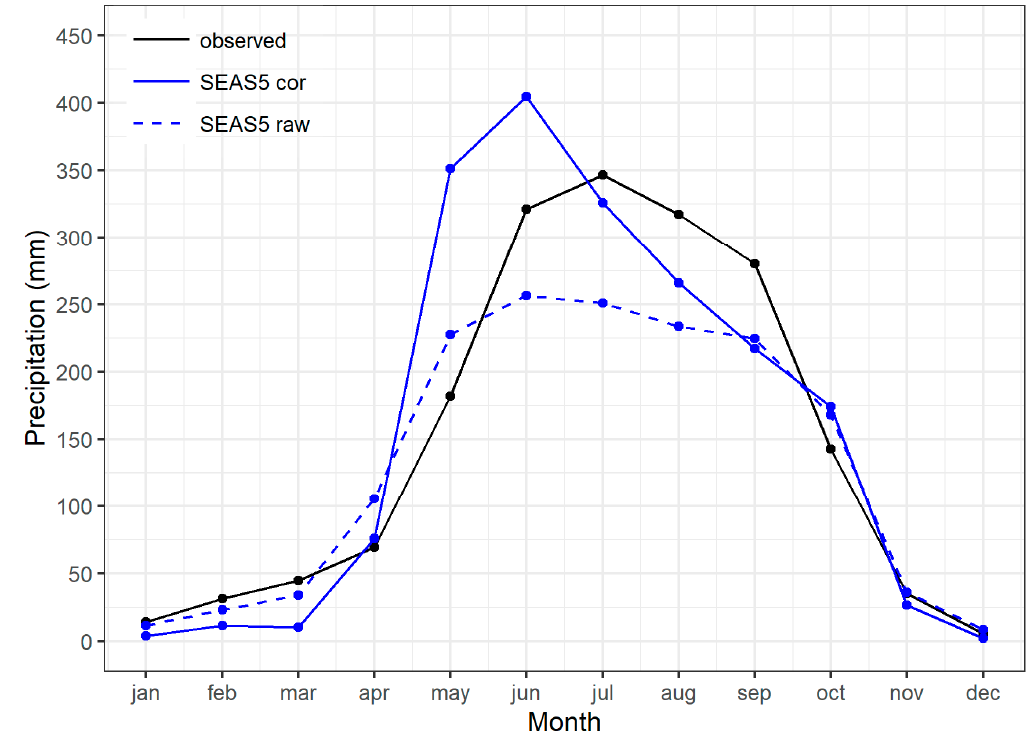
Figure 2. Mean monthly climatology for the period 1981–2016 of the raw and the bias-corrected SEAS5 hindcasts concerning observations for Khulna station.